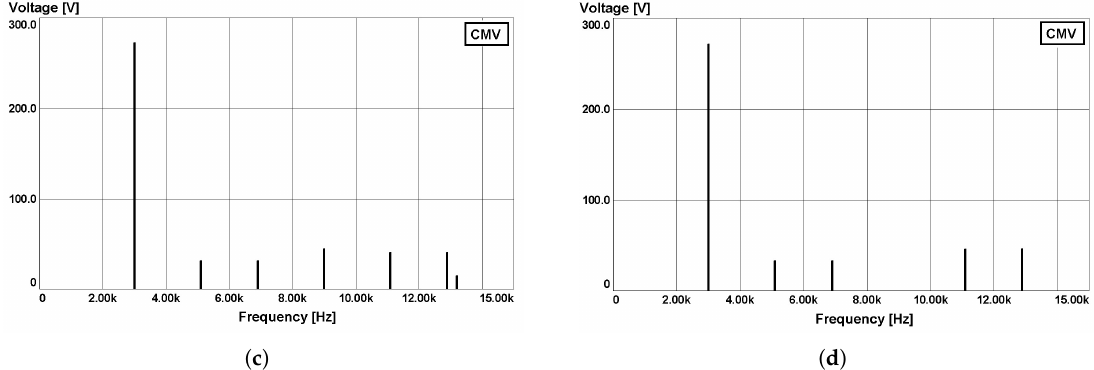
Figure 14. Comparison of using different modulations: ( a ) sinusoidal modulation, ( b ) triangular modulation, ( c ) harmonics spectrum in the common-mode (CM) voltage using the sinusoidal modulation, ( d ) harmonics spectrum in the CM voltage using the triangular